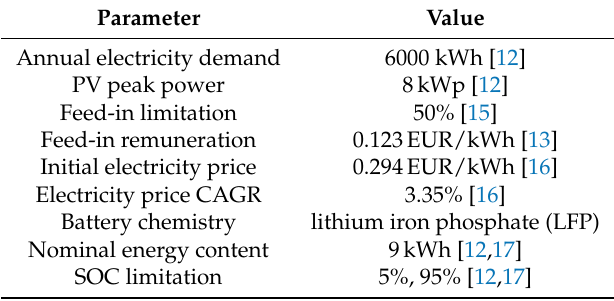
Table 1. Main parameters for the prosumer building and the home energy storage system